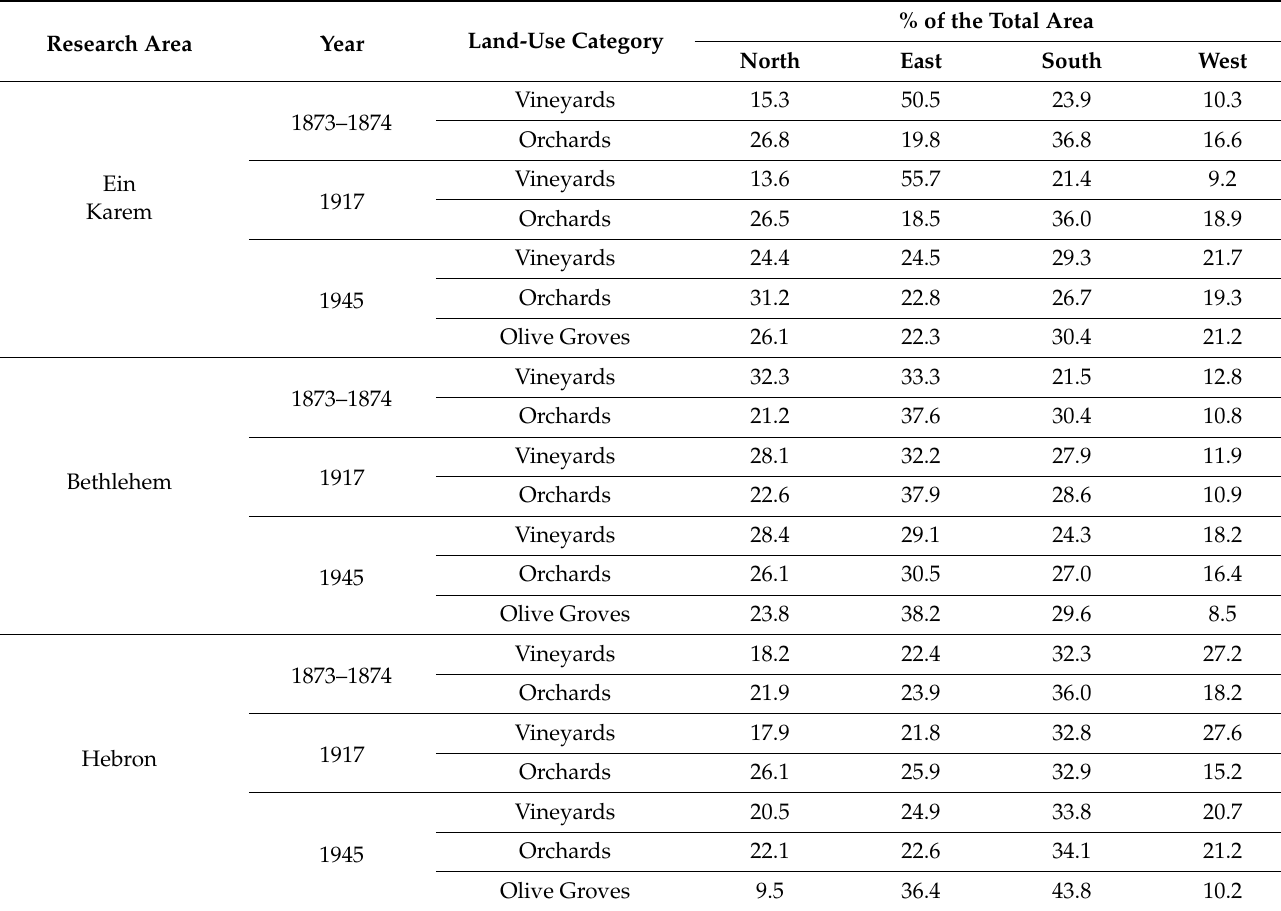
Table 5. The downhill direction in relation to the sun. Each research area, shown on the left side, is subdivided into one of the three periods (1873–1874, 1917, and 1943–1945) and then further subdivided into land-use categories (vineyards, orchards and olive groves). The upper columns preset the percentage out of the total area that shows the division into four downhill directions in relation to the sun—north, east, south, and west. Research